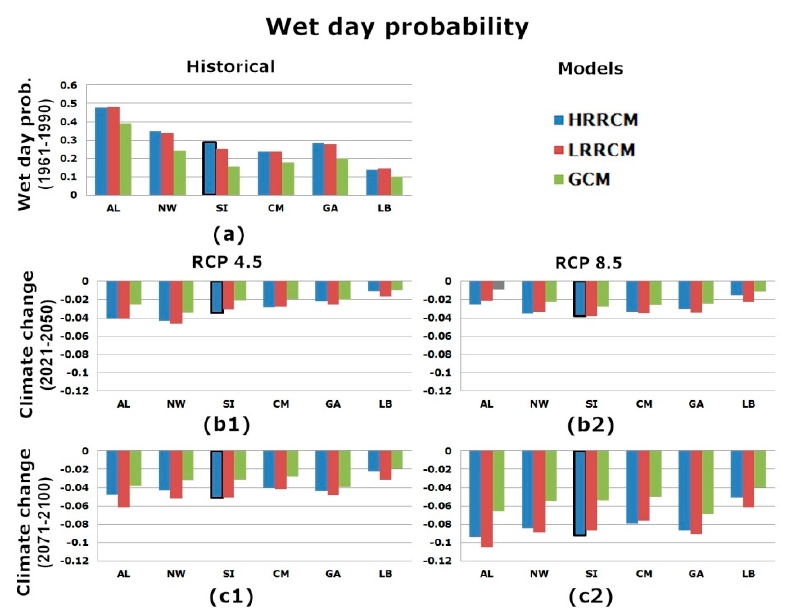
Figure 6. Wet day probability values (from 0 to 1) and their changes with global warming for the six boxes shown in Figure 1c and for the three simulations HRRCM (blue), LRRCM(red), GCM (green). Panel ( a ) shows the probability of wet days in the reference period (1961–1990). The panels in the second and third row ( b1 – c2 ) show the probability di ff erences for the near-term (2021–2050) and the long-term (2071–2100) with respect to the reference period (1961–1990) for the scenario RCP4.5 (first 1) and RCP8.5 (column 2). Grey bars indicate that the climate change signal is not statistically significant (Alps, panel b2). Bold borders of the HRRCM bars for the South Italy box denote that its results are statistically di ff erent with respect to the